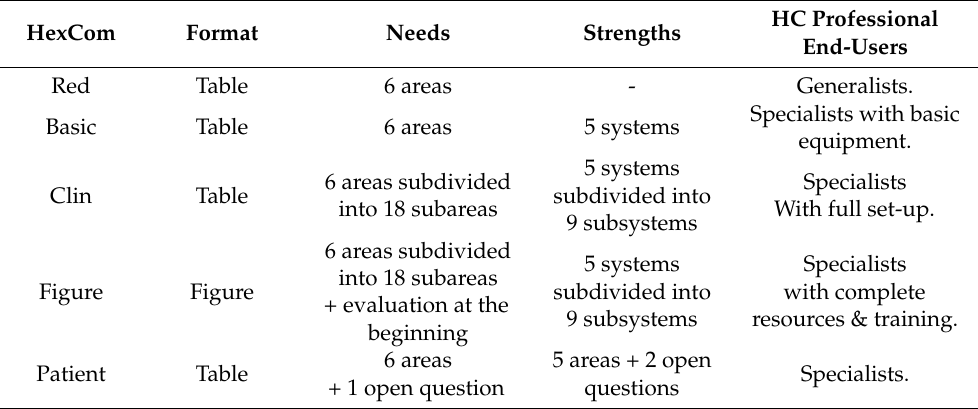
Table 1. Instruments derived from the HexCom model.